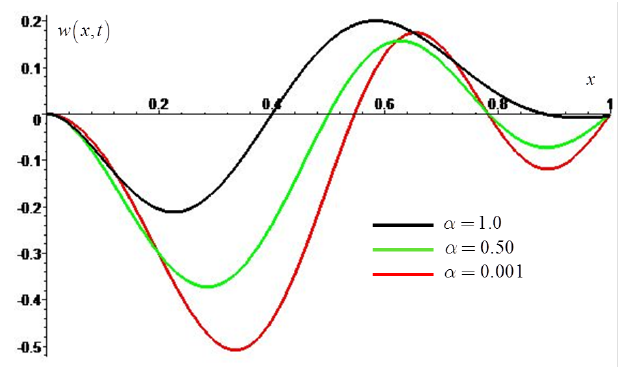
Fig. 4. The resultant deflection for various nonhomogeneity parameter ˛